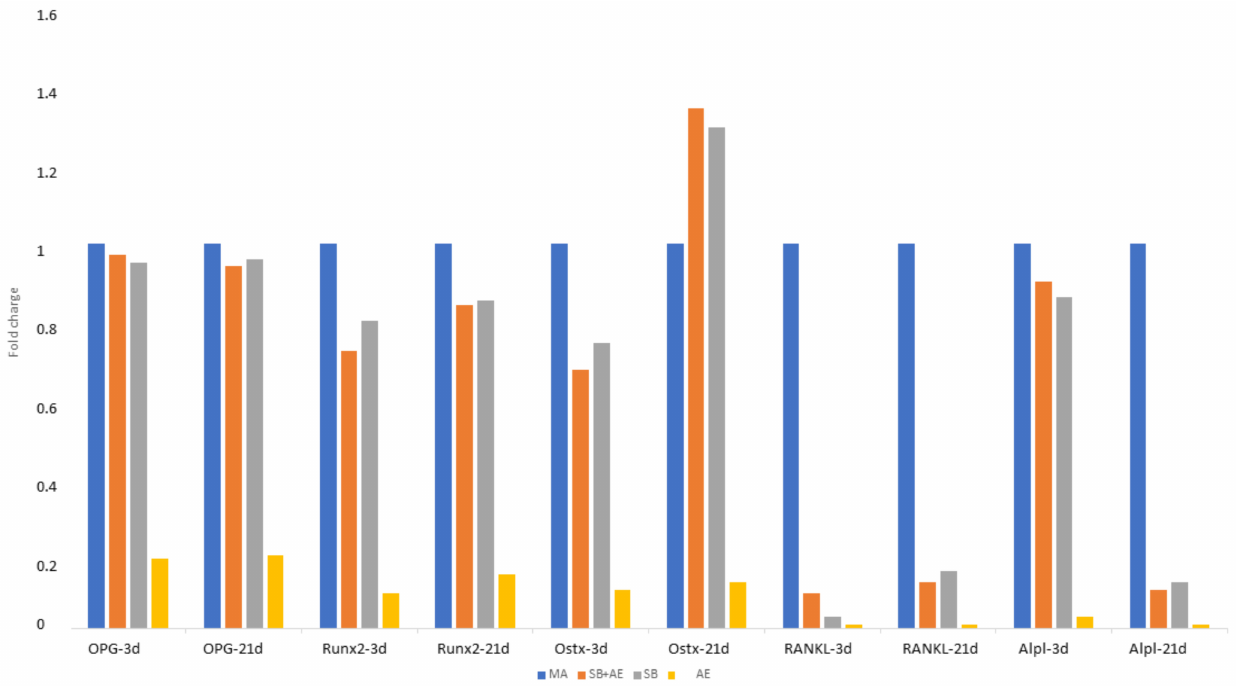
Figure 6. Gene expression of SaOS-2 osteoblastic cells at 3 and 21 days for the different topogra- phies